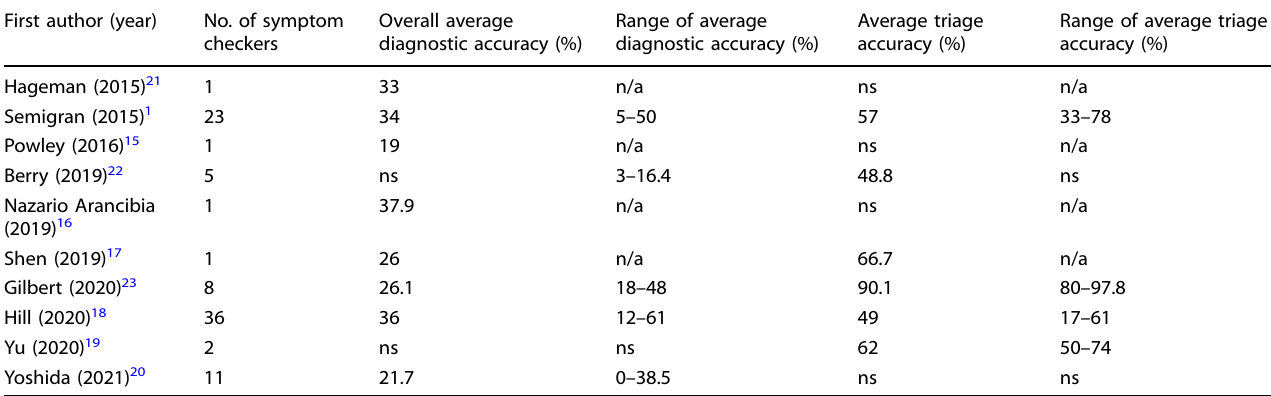
Table 2. Overall and range of average diagnostic and triage accuracy of symptom checkers in each study.